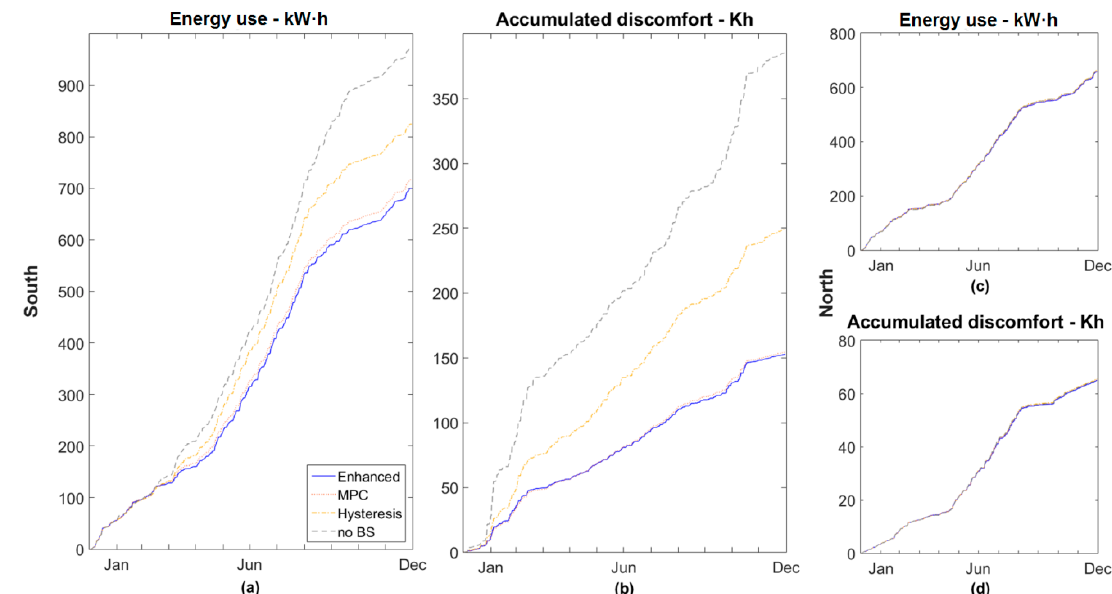
Figure 9. Accumulated energy use ( a , c ) and thermal discomfort ( b , d ) in north and south office orientations for the studied controls.